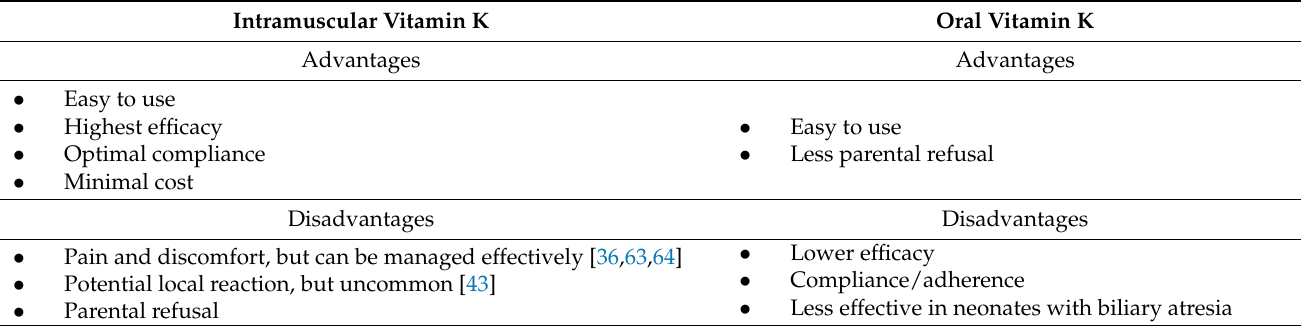
Table 9. Pros and cons of intramuscular and oral prophylactic administration of vitamin K. Intramuscular Vitamin K Oral Vitamin